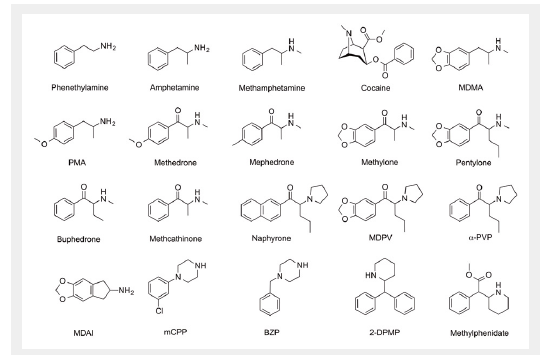
Structures of representative novel psychoactive substances (stimulants and empathogens). Chemically, the substances shown include amphetamines (amphetamine, methamphetamine, MDMA, PMA), cathinones (β-keto-amphetamines such as methedrone, mephedrone, methylone, pentylone, buphedrone, methcathinone, naphyrone, MDPV or α-PVP), an aminoindane (MDAI), piperazines (mCPP and BZP) and pipradrols (2-DPMP and methylphenidate). Pharmacologically, these substances are psychostimulants or empathogens and primarily interact with monoamine transporters.